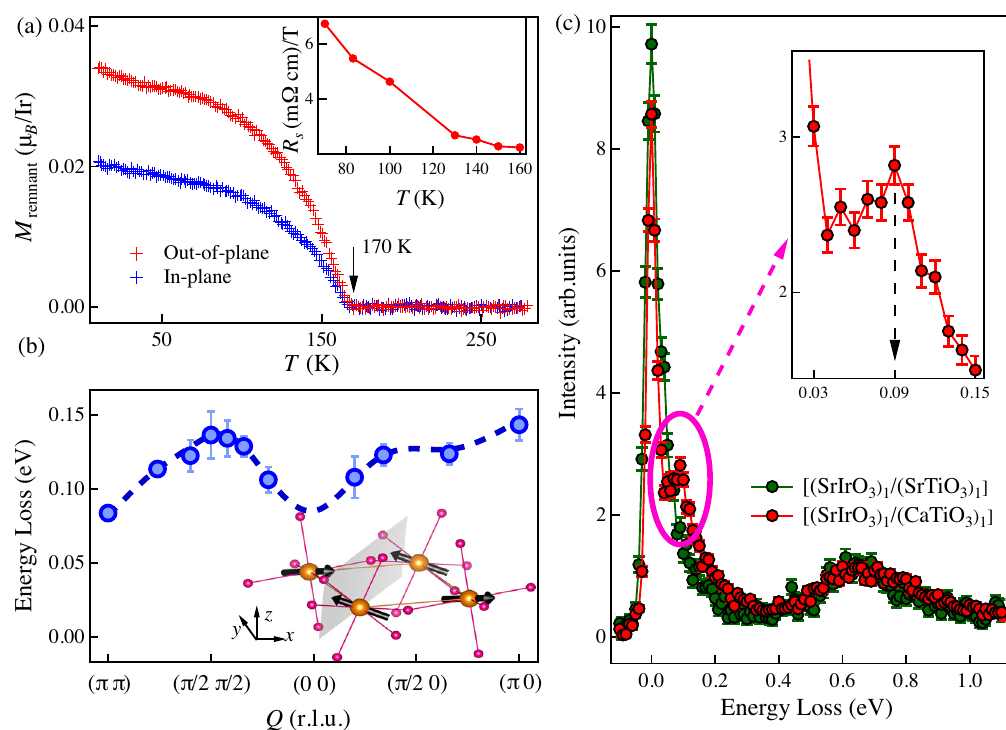
FIG. 5. Magnetic structure and low-energy magnetic excitations. (a) Temperature-dependent out-of-plane (red) and in-plane (blue) remnant magnetization ( M ). Inset shows the temperature dependence of R remnant Brillouin zone. The errors are statistical from the fitting with dashed line as a guide to the eye. Inset shows the ground-state magnetic ¼ 1 = 2 magnetic moments are represented as black arrows. (c) RIXS spectra at Q ¼ ð π ; π Þ of the SL (red) and pattern of the SL. The J eff ½ð SrIrO Þ ð SrTiO Þ (cid:2) (green) measured at 35 K. The magnon excitation feature is indicated by an ellipse. Inset shows the expanded 3 3 1 = 1 view of the magnon